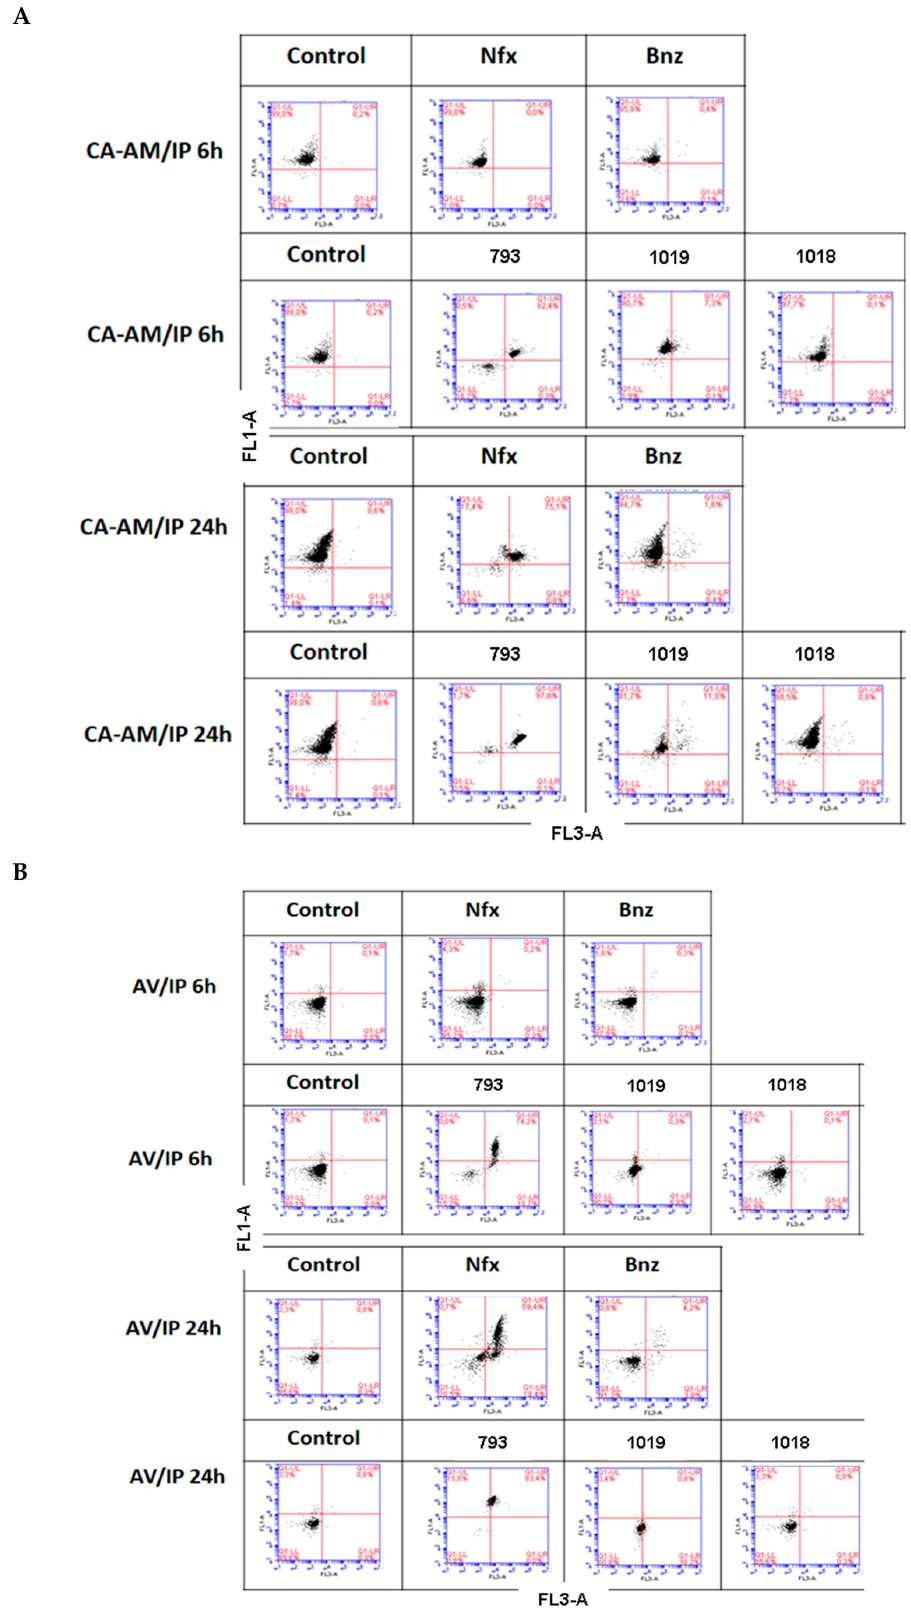
Figure 3. Analysis of the viability and mechanism of death by flow cytometry in parasites at 6 and 24 h of incubation at a 20 × IC 50 concentration of Nfx , Bnz , 793 , 1019 , 1018 . ( A ) CA-AM/IP labeling. ( B ) AV/IP